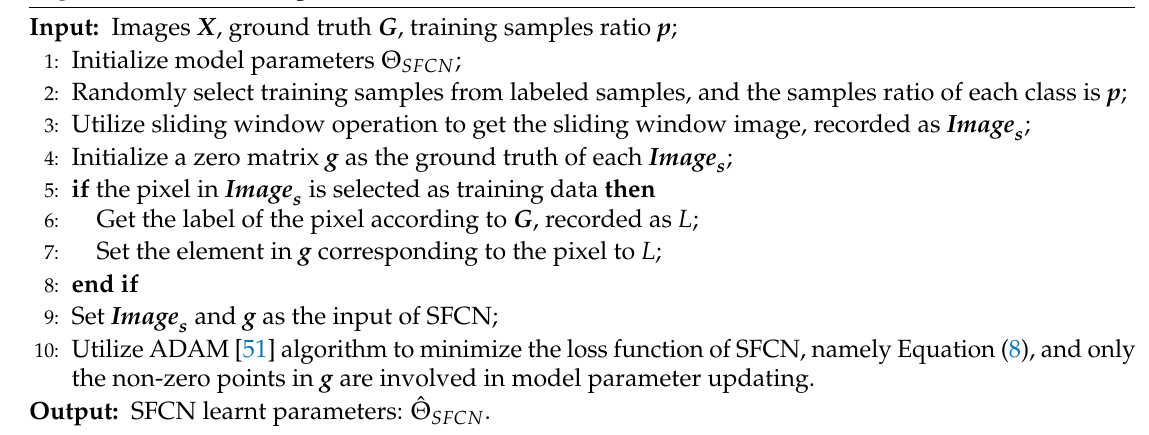
Algorithm 1 The training framework of